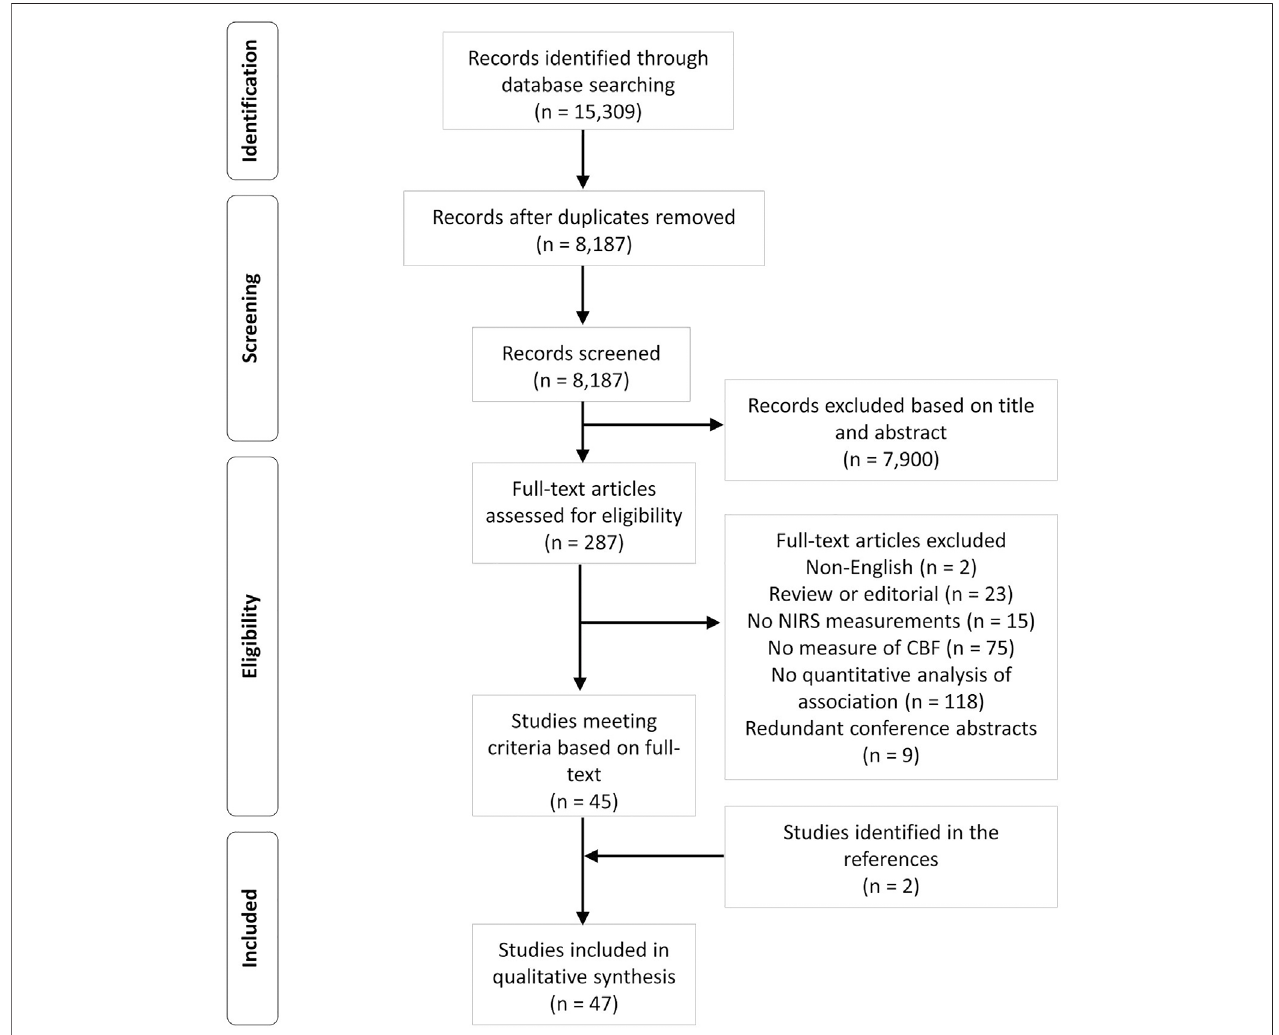
FIGURE 1 | A PRISMA fl ow-diagram of the systematically conducted scoping review of the literature.